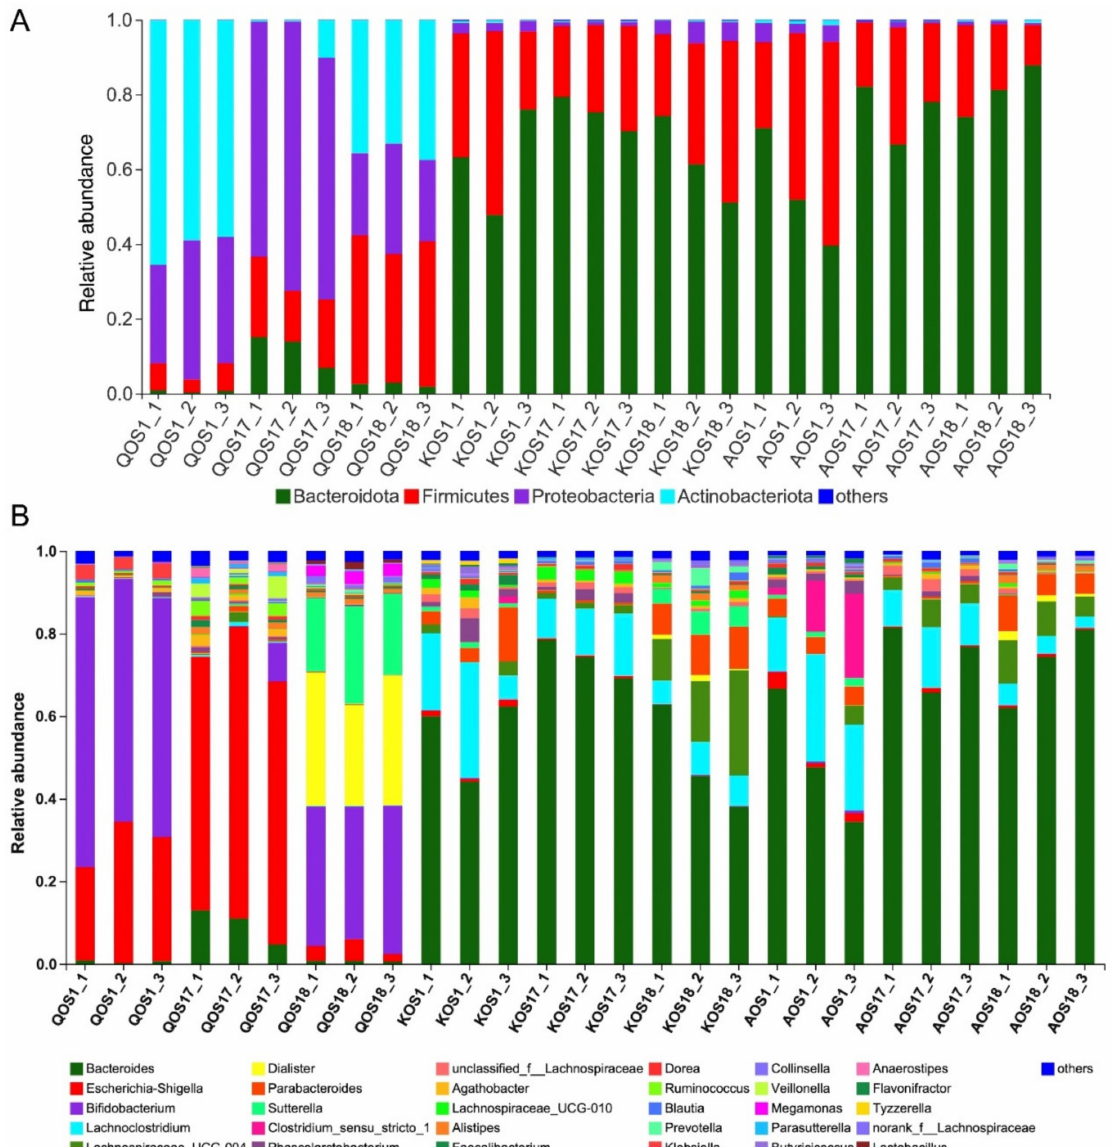
Figure 4. Compositional analysis of the gut microbiota. Microbiota composition at the phylum level ( A ) and genus level ( B ). QOS1 denotes fermentation of QOS by gut microbiota F1. QOS17 denotes fermentation of QOS by gut microbiota F17. QOS18 denotes fermentation of QOS by gut microbiota F18. Each fermentation group has three replicates. KOS and AOS were labeled using the same format. QOS, AOS, and KOS are composed of unique monosaccharides and have structurally different glycosidic linkage modes. Previous studies have indicated that different gut bacteria have different classes of carbohydrate-active enzymes (CAZymes) [17–19], and, since CAZymes are required for the metabolism of marine algae oligosaccharides [19,20], it is therefore reasonable that different enterotypes of human gut microbiota would have varying effects on the fermentation processes of QOS, KOS, and